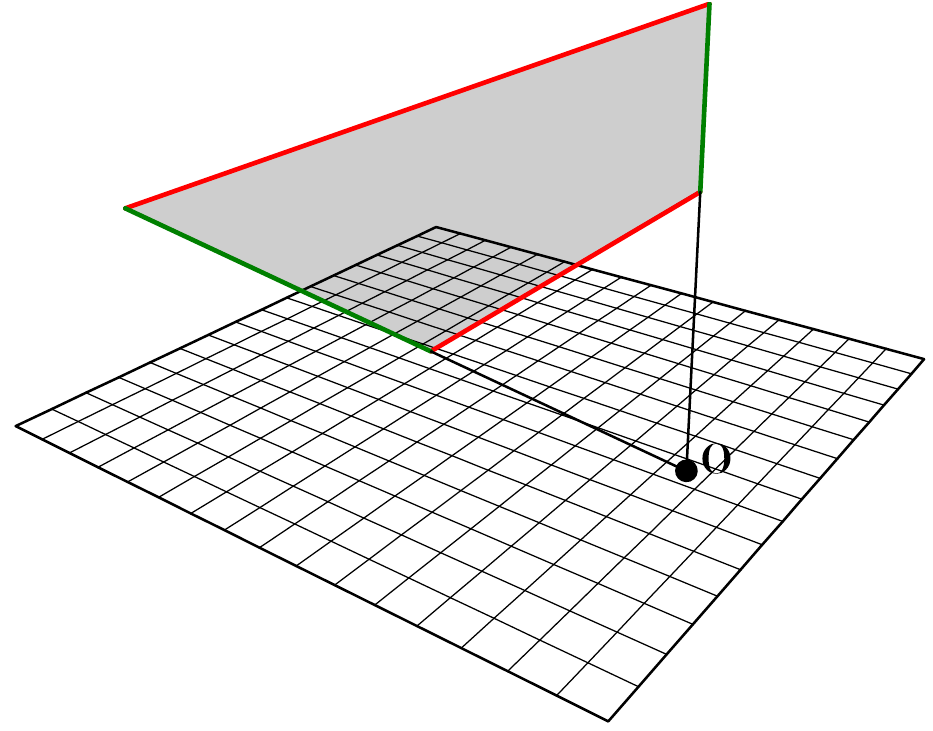
Figure 5. Two parallel homothetic lines (red), scale origin, two radial edges (green) and resulting planar quadrilateral.